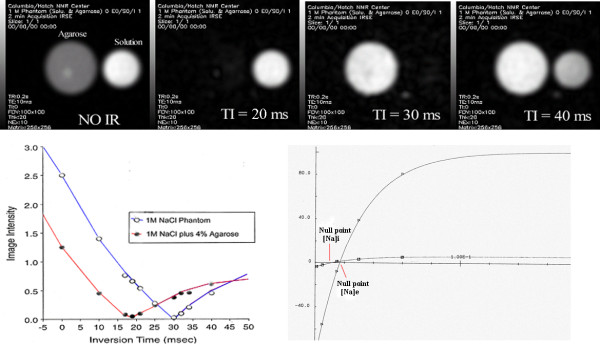
(Top row) The phantom consists of two tubes, one is 1 M NaCl in solution and the other is 1 M NaCl in 4% agarose (Panel A). They simulate extracellular and intracellular sodium, respectively without use of inversion recovery pulse. It can be seen that an inversion time of TI = 20 ms completely suppressed intracellular sodium (Panel B) and TI = 30 ms completely suppressed the extracellular sodium signal from the tube containing NaCl in solution (Panel C). At TI = 40 ms partial suppression of extracellular sodium is highlighted (Panel D). (Middle row) Two 1 M NaCl phantom image intensities (with 4% agarose, open circles; and, without 4% agarose, closed circle) were plotted during single quantum acquisition and for 9 different inversion recovery times (TI) showed two distinct null points shown at right.